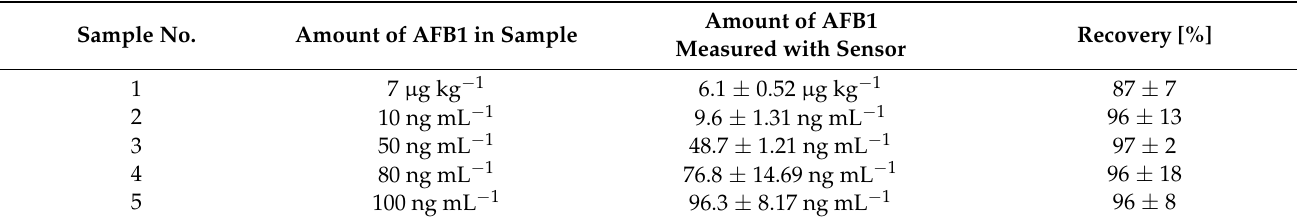
Table 3. AFB1 detection in wheat and maize flour samples; Sample 1 was maize extract originally containing AFB1 whereas samples 2–5 were spiked samples; n = 5 in all experiments; Reproduced with permission from [68], © Elsevier. Sample No.